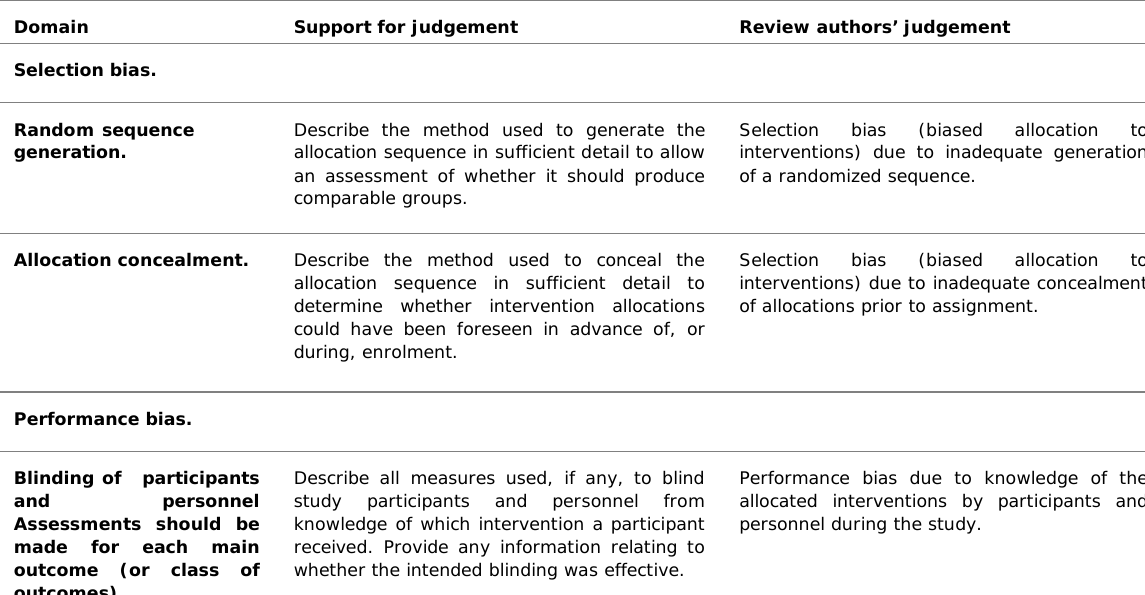
Table A2. The Cochrane collaborative tool for assessing the risk of